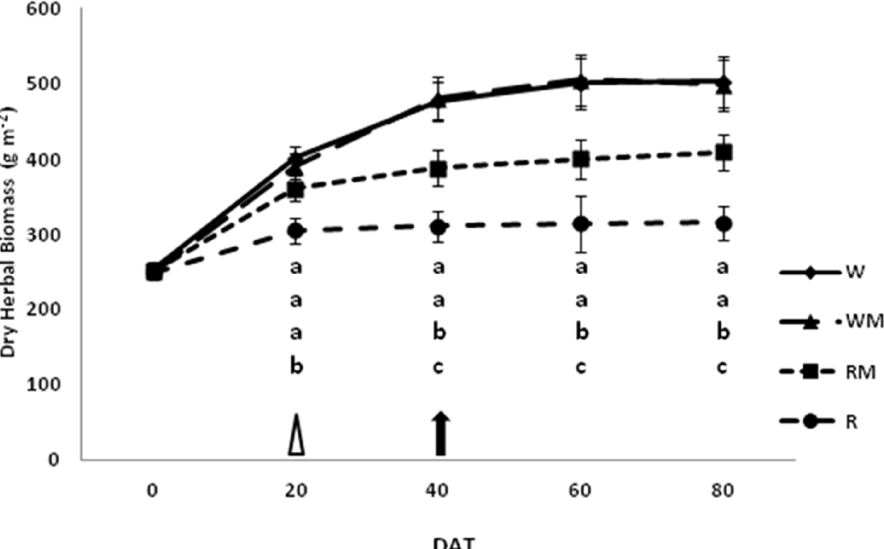
Figure 2. Changes in dry herbal biomass (g m − 2 ) of spearmint exposed to the following treatments: R—rainfed without straw mulch, RM—rainfed with straw mulch, W—well-watered control plants and WM—well-watered with straw mulch. Measurements were performed 0, 20, 40, 60 and 80 days after the onset of the treatments (DAT). Vertical bars represent ± SE of the mean ( n = 5). Bars with different letters indicate significant differences among treatments in the given DAT at p ≤ 0.05. Triangle at 20 DAT indicates the early bloom, and arrow at 40 DAT indicates the full bloom, in overall treatments.